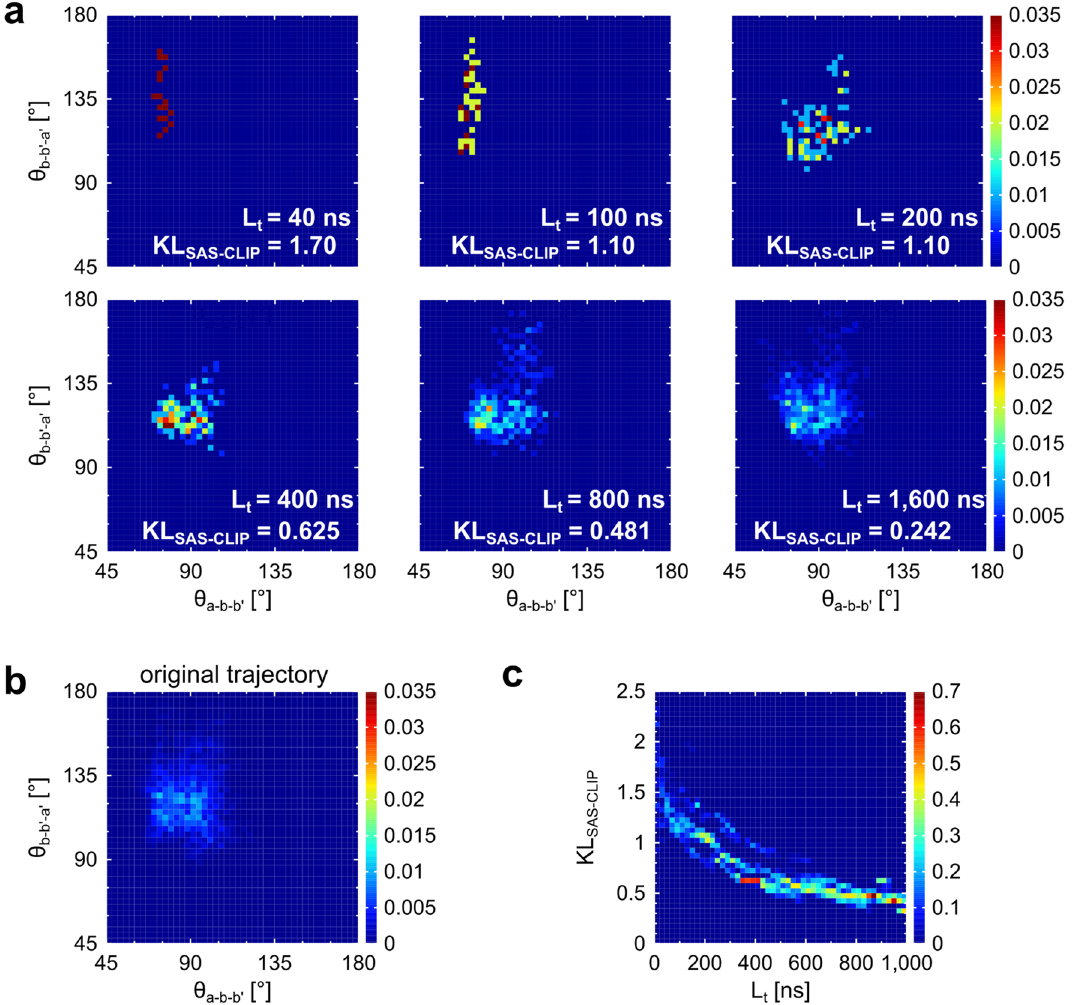
Figure 3. Relationship between L t and KL SAS-CLIP . ( a ) Domain conformations of several clipped time series with various L t . These were clipped from the same CGMD trajectory as the #A-2. All satisfy χ 2 < 3.0. The colors in the heatmaps show the appearance probability in the (θ a-b-b ′ , θ b-b ′ -a ′ ) space. The pixel with the probability > 0.035 is presented in the same color as that with the probability of 0.035. ( b ) The distribution of the entire CGMD trajectory before clipping time series in ( a ). ( c ) The distribution of the KL SAS-CLIP for the total of 19,315 time series. They were clipped from the same CGMD trajectories as the #A-1, #A-2, and #A-3. Each satisfies χ 2 < 3.0. The colors show the appearance probability of the KL SAS-CLIP for each L t